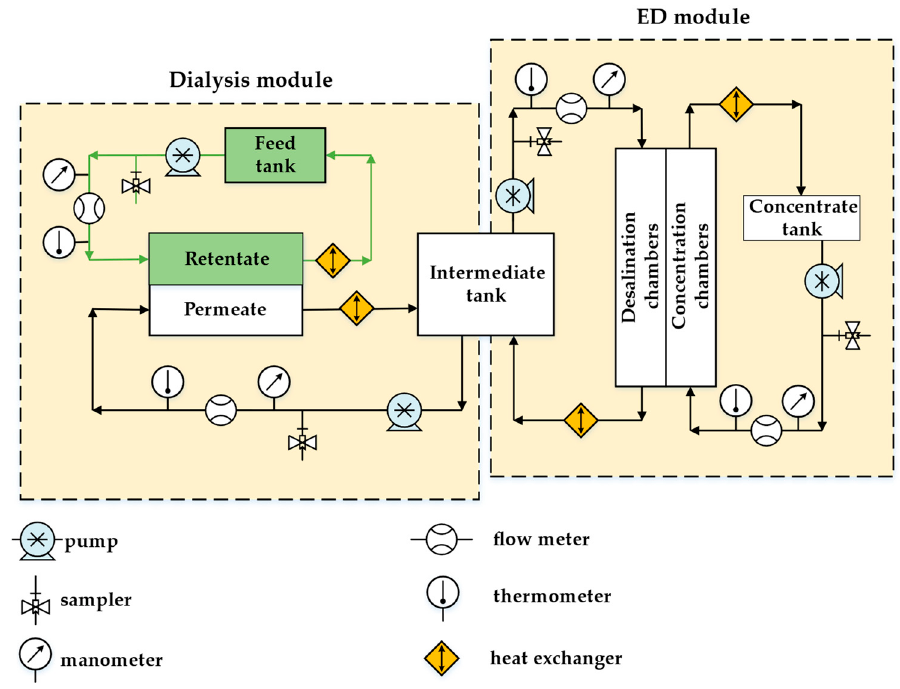
Figure 2. Simplified scheme of the pilot scale installation.